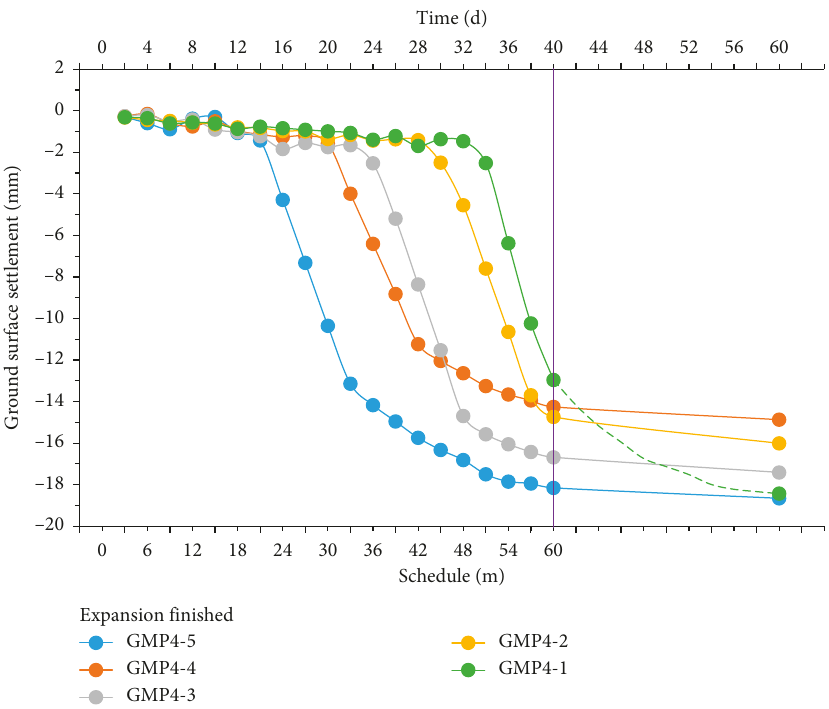
Figure 10: Settlement of GMP4-1 ∼ 5 during the